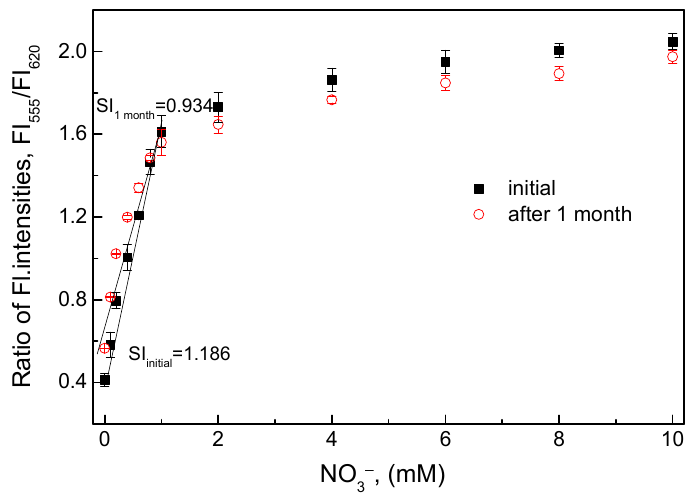
Figure 7. Change in the ratiometric fluorescence intensities of the O17-HT-EC membrane in the nitrate concentration range of 0.1–10 mM at initial use and after 1 month.